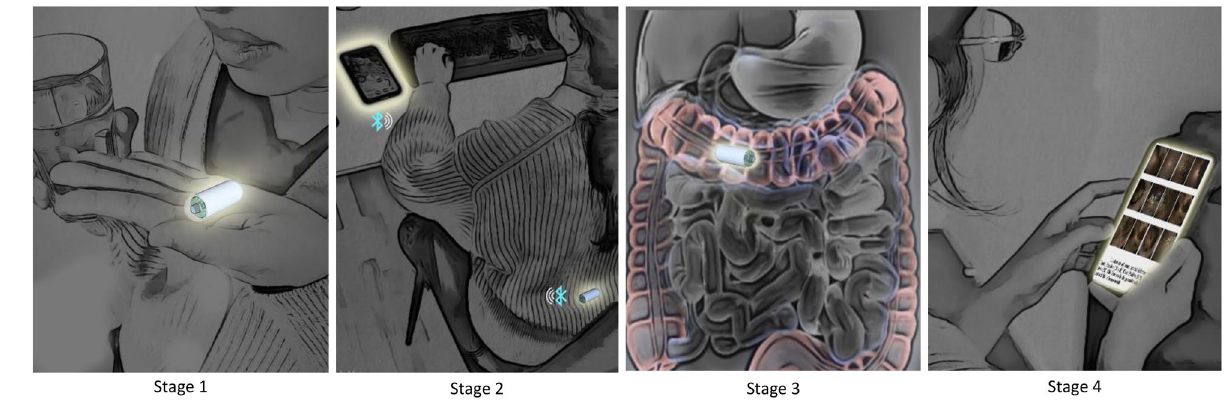
Figure 1. The 4 stages illustrating the use of our camera